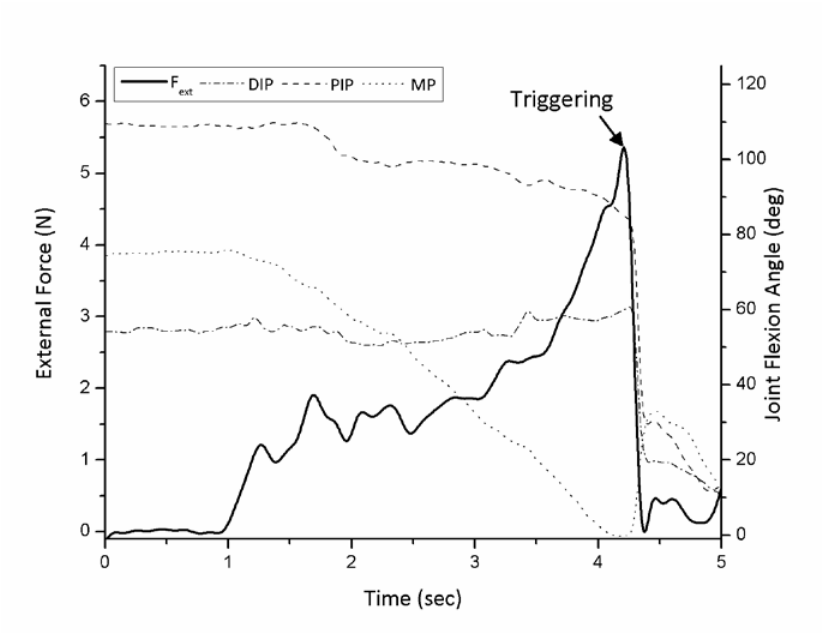
Figure 2 Joint angles and resistance force from flexion to extension in a trigger finger digit. At the moment of triggering, the finger flexor pulley system was considered to be in static equilibrium. Previously published as Figure 4 in Lu, S. C., Kuo, L. C., Jou, I. M., Wu, C. C., Tung, W. L., Sun, Y. N. and Su, F. C., Quantifying catch-and-release: